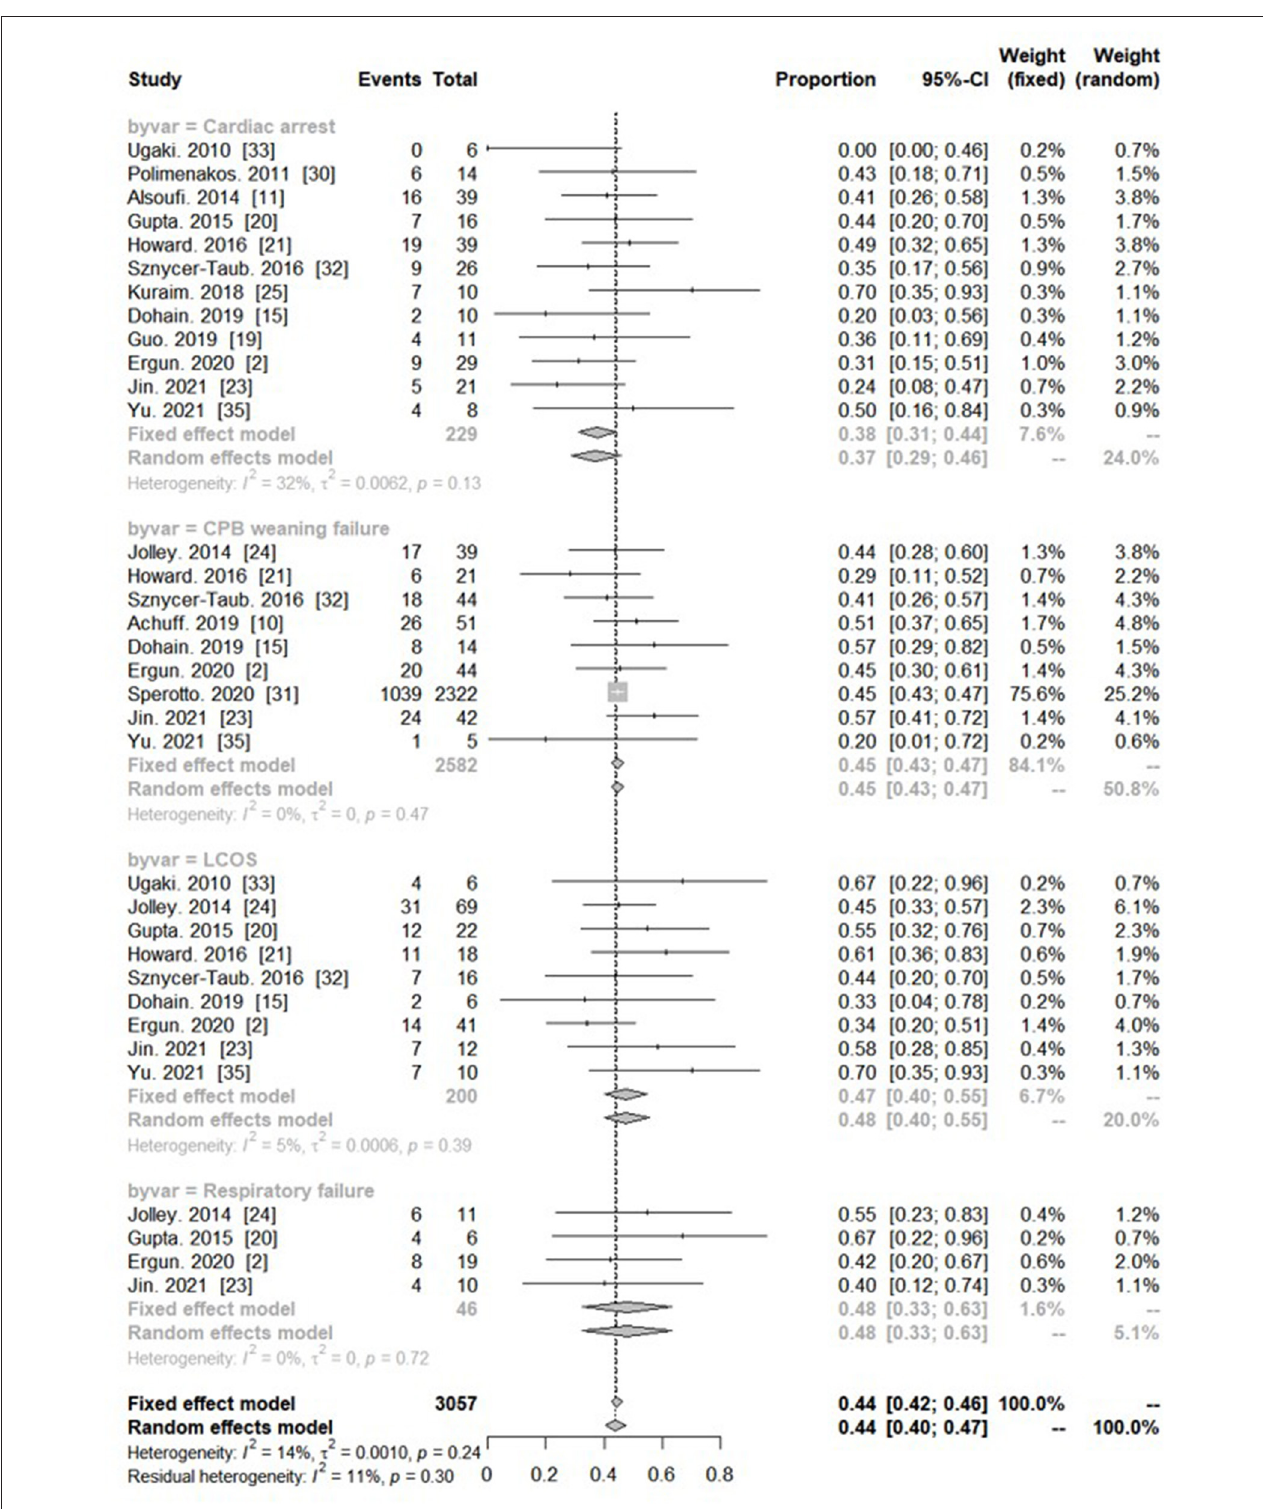
FIGURE 4 | Forest plot showing subgroup analysis of proportional survival in different indications with post-cardiotomy extracorporeal membrane oxygenation.